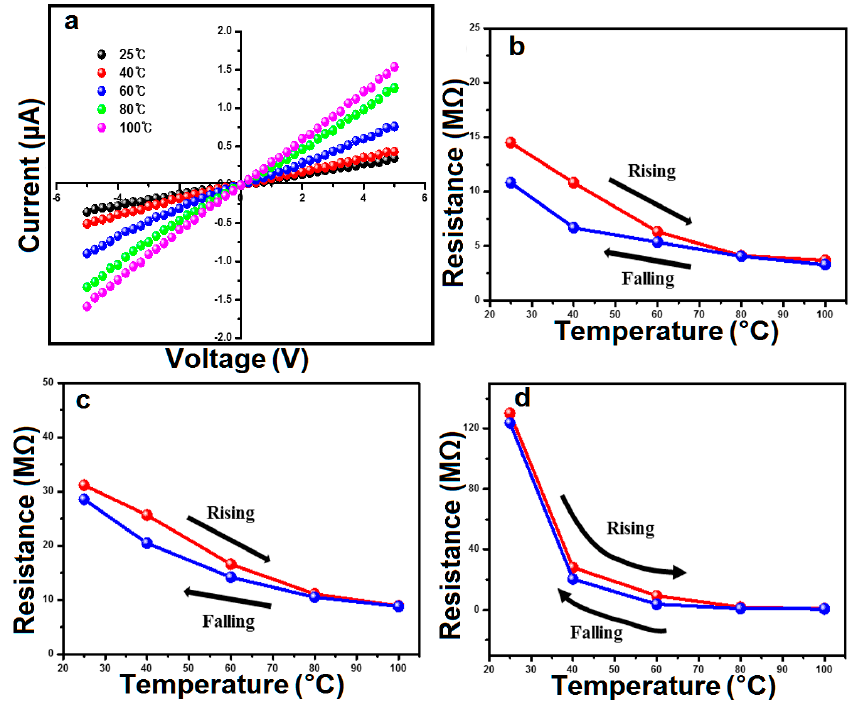
Figure 5. ( a ) Variation of the electrical properties of ZnO/V 2 O 5 temperature sensor at different tem- perature conditions. Resistance–temperature relation of ZnO/V 2 O 5 temperature sensor for seed layer deposition time of ( b ) 10 min, ( c ) 20 min, and ( d ) 30